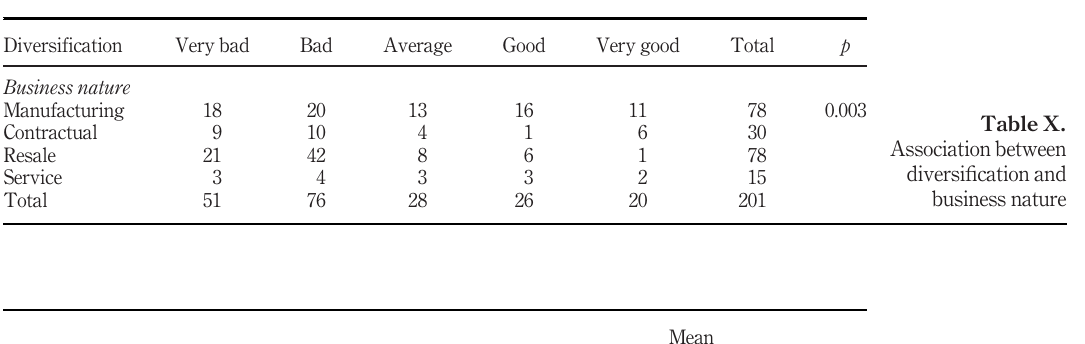
Table XI. Relationship